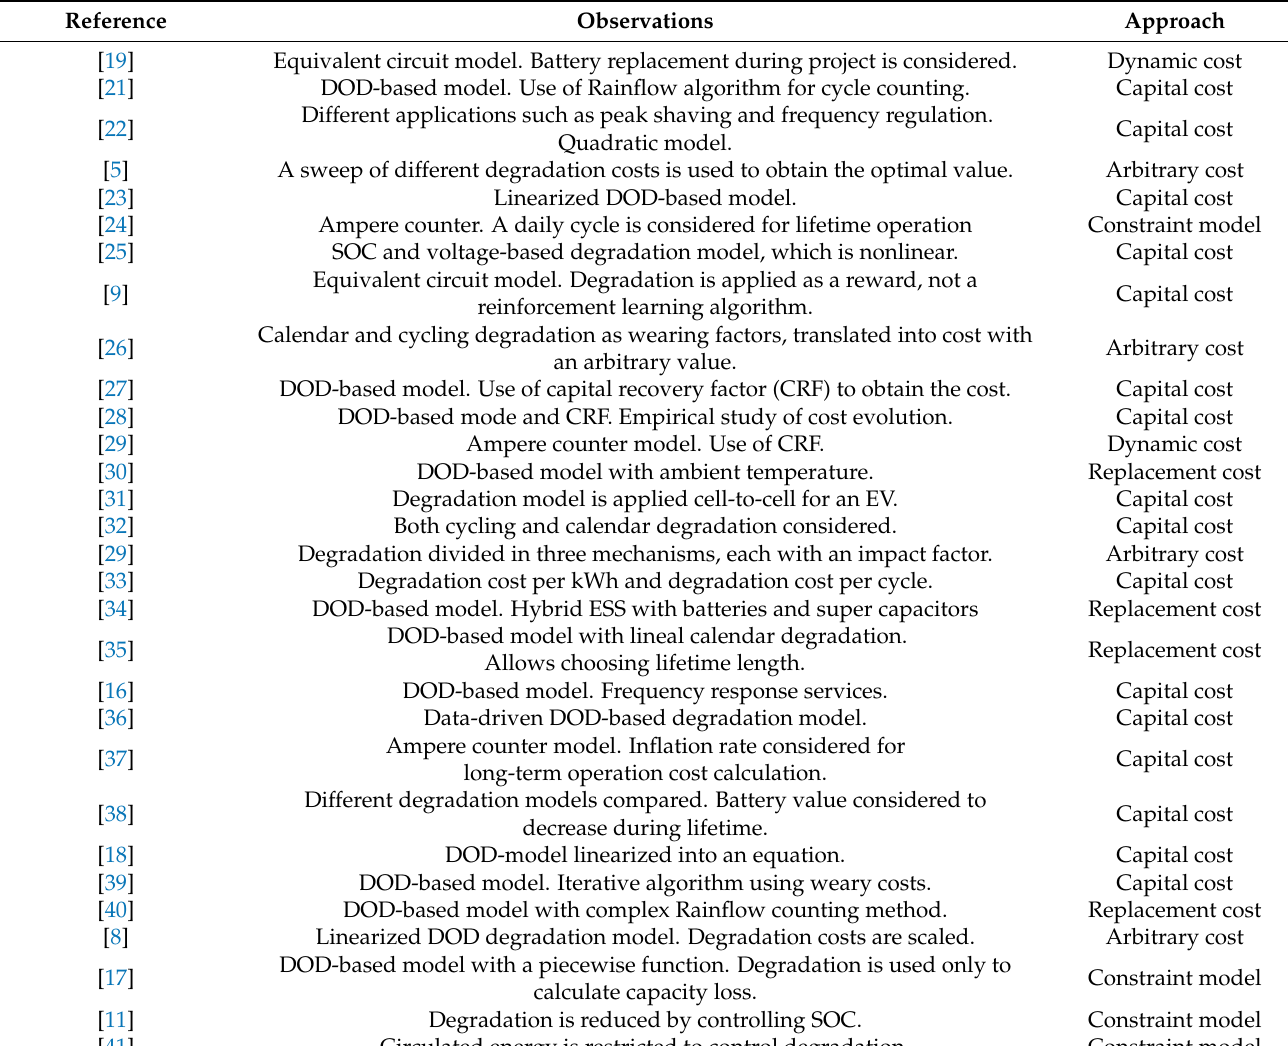
Table 1. Literature review